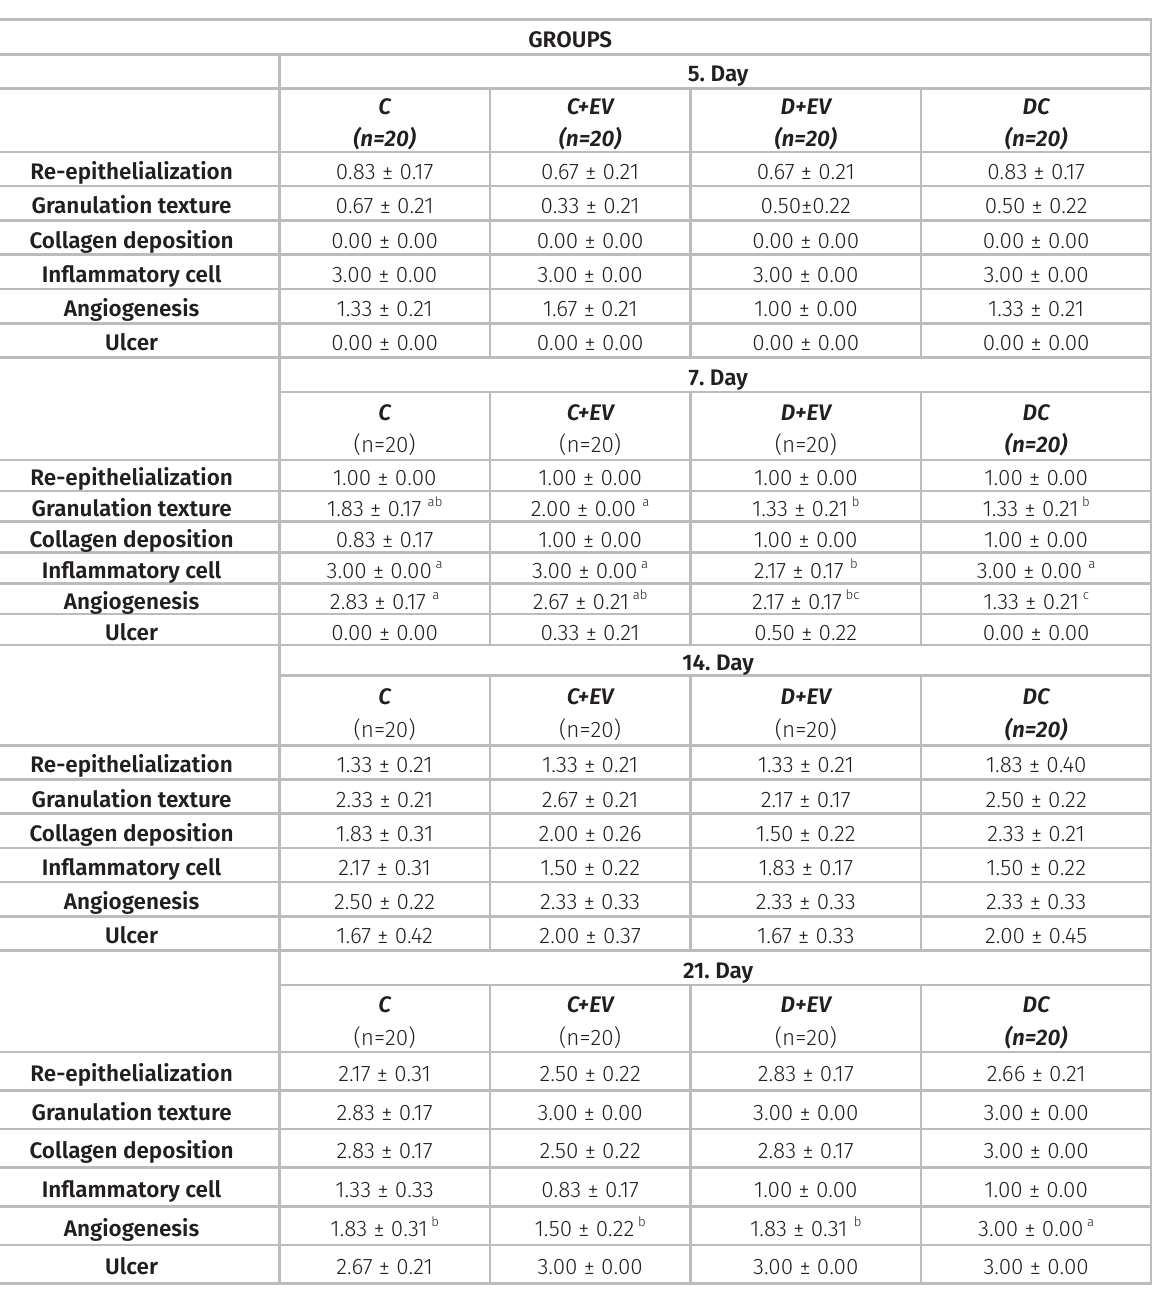
Table I. Histopathological findings on days 5, 7, 14, and 21 of wound healing.